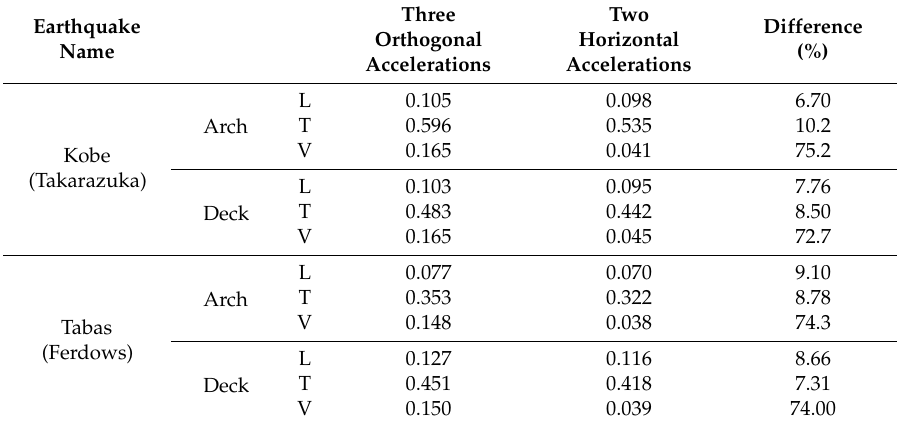
Table 8. Effect of vertical component displacement of the deck and arch crown